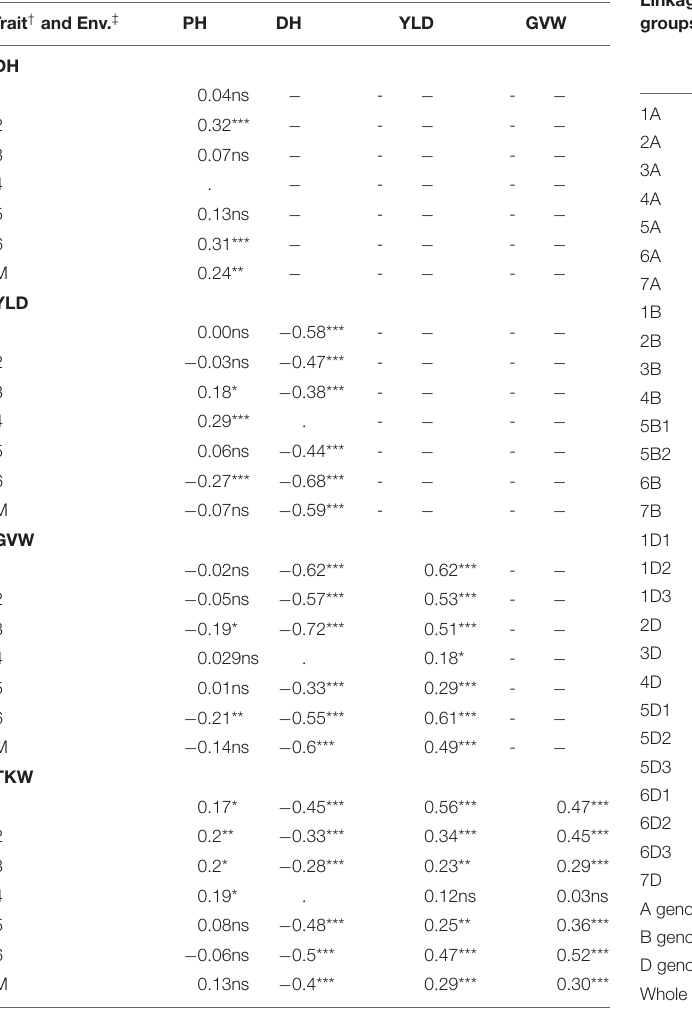
TABLE 4 | Distribution of markers across linkage groups in the genetic map developed using the Reeder × Albany RIL population. Linkage No. of No. of Map Average map Average map groups markers unique length density density loci